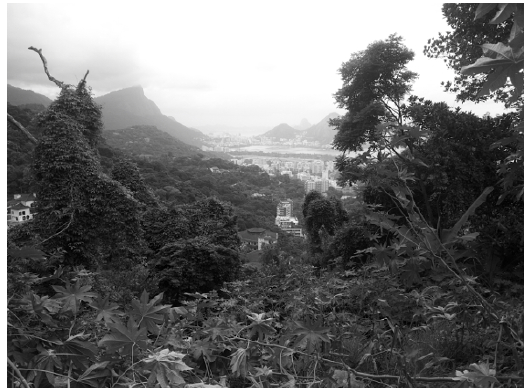
Figure 12. View from the Laboriaux